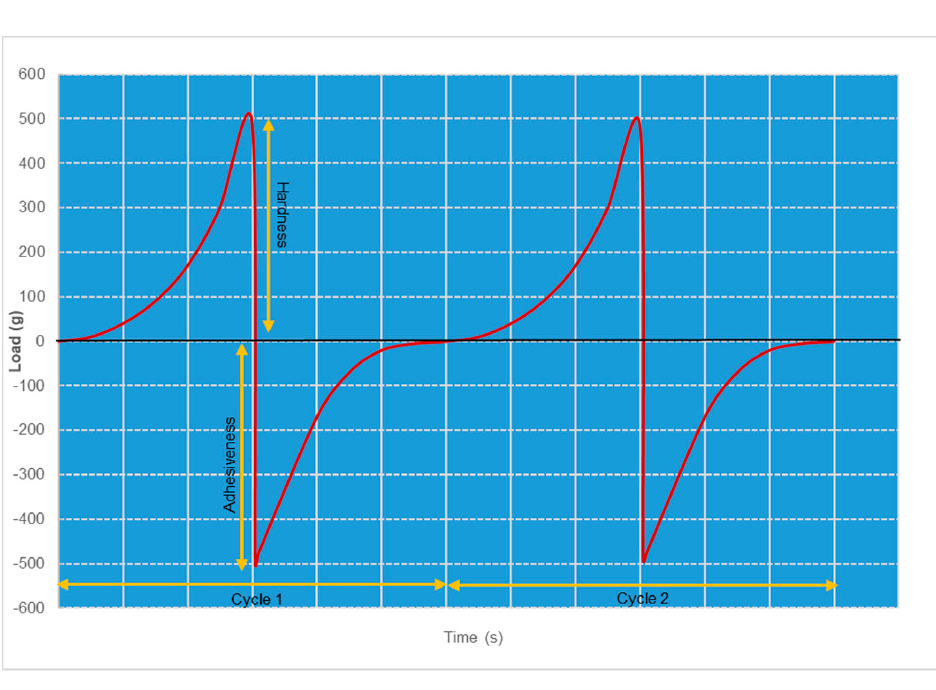
Table 1. Various derived parameters for the percutaneous penetration of chrysin from nanoemulgel and simple gel.